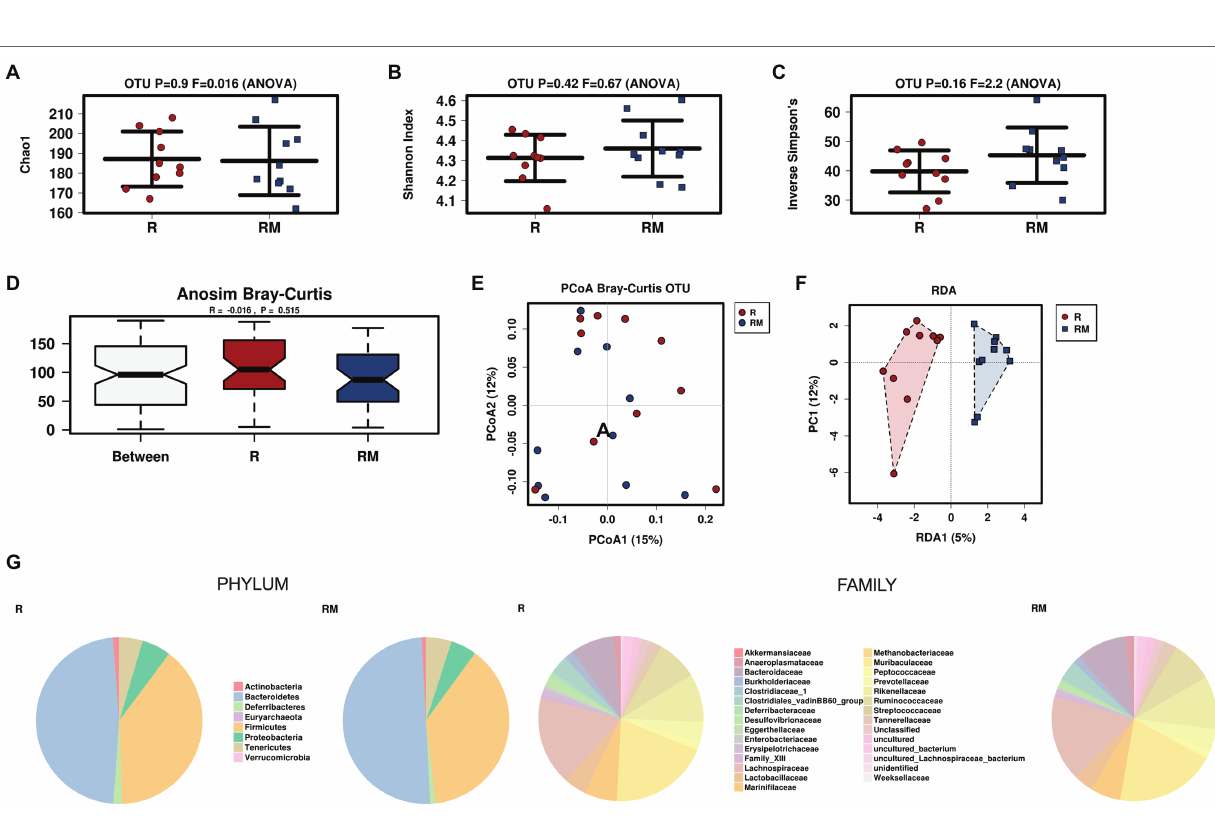
FIGURE 2 | Alpha diversity markers (A-C) , beta diversity analysis (D-F) , and relative abundances of the two groups (G) . The redundancy analysis (RDA) revealed a value of p of 0.551. R, reuterin supernatant (reuterin group); RM, biotransformation medium (reuterin medium